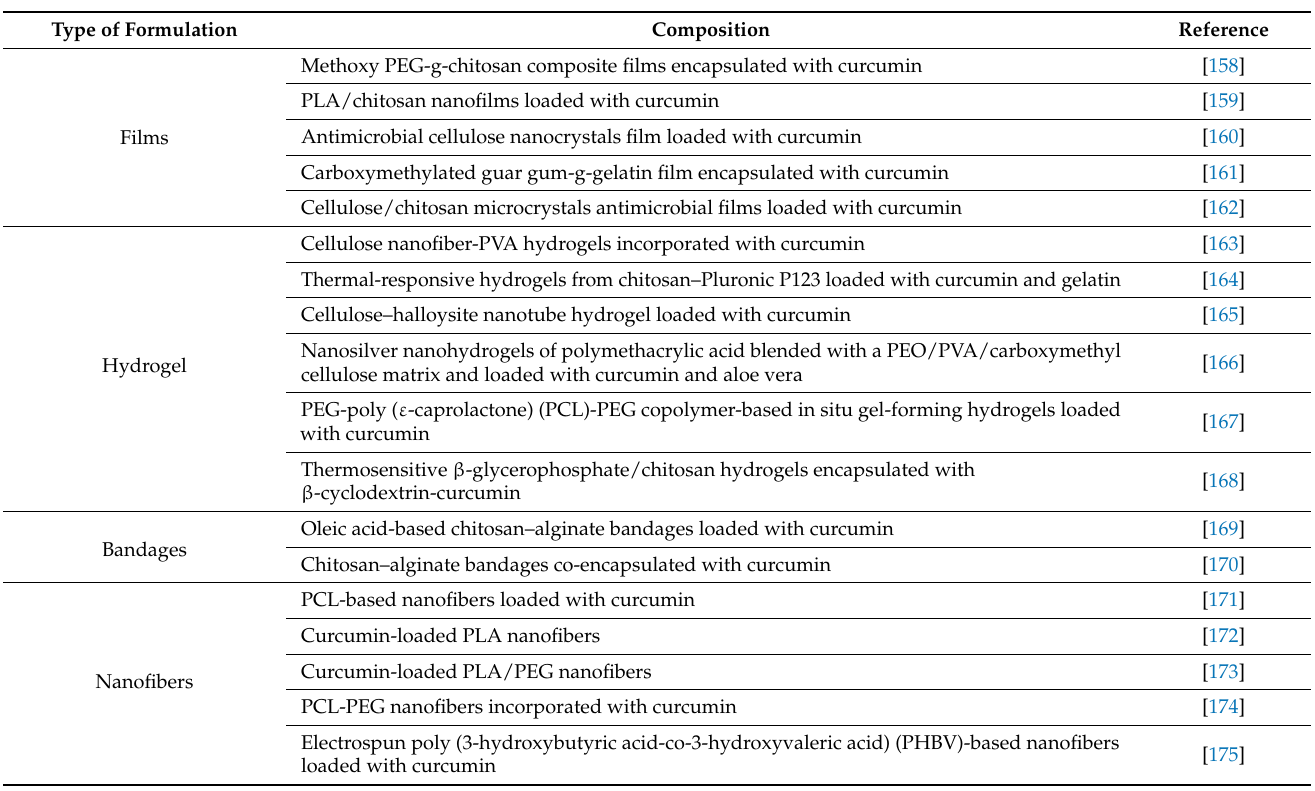
Table 3. Various formulations loaded with curcumin for wound healing application. Type of